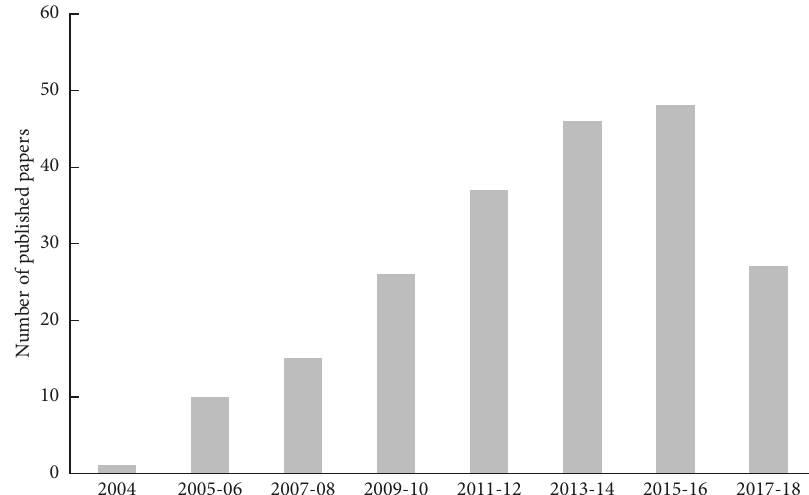
Figure 1: Number of papers published in the last 15years on essential oils.